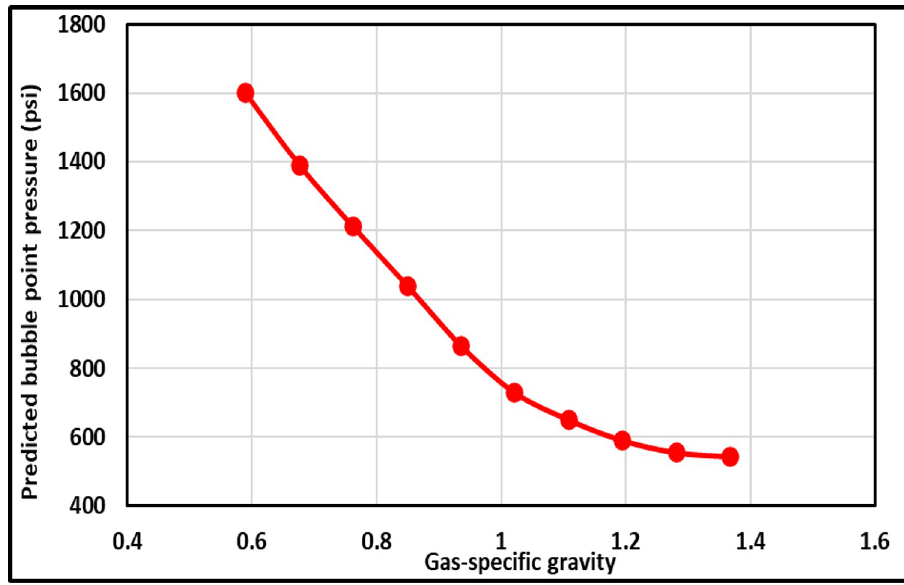
Fig 8. γ g TrA of proposed ANFIS